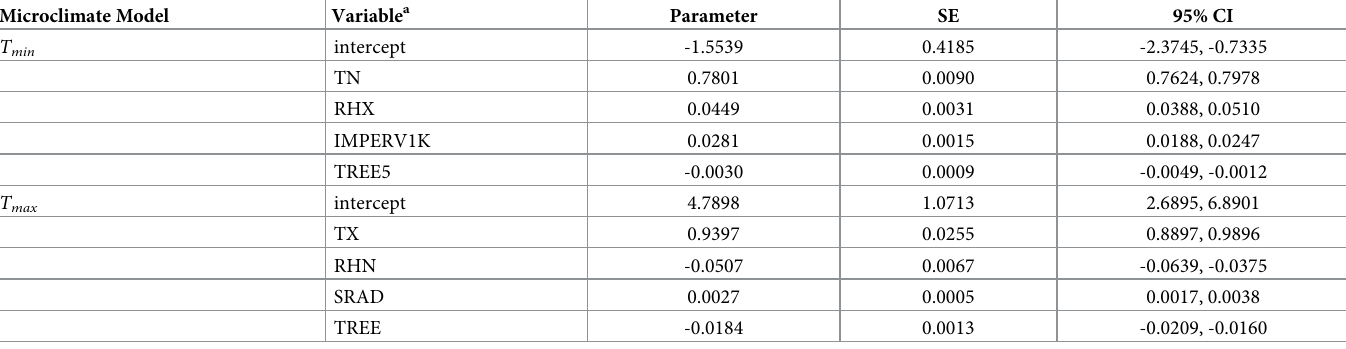
Table 2. Linear regression models used to predict minimum and maximum daily temperatures as a function of macroclimate and land cover variables. Variable codes are defined in Table 1. Microclimate